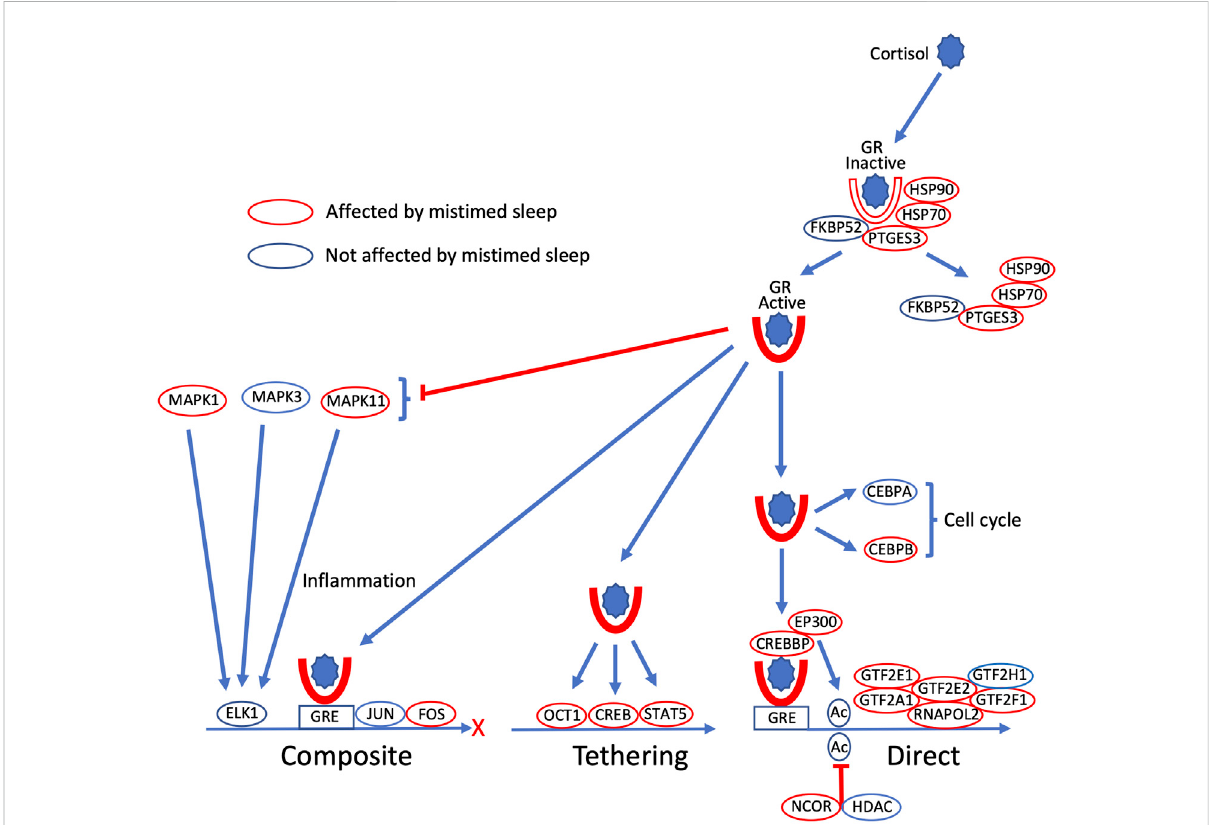
FIGURE 2 Glucocorticoid gene expression regulatory signalling pathways are disrupted by sleeping out-of-phase. Cortisol binds to cytoplasmic glucocorticoidreceptors (GR),whichbecomeactivewhenasetofboundchaperoneproteins(FXBPS2,PTGES3,HSP70,HSP90)dissociatefromGR. Active GR regulates gene expression in three major ways: GR binds to glucocorticoid response elements (GRE) in conjunction with other transcriptionfactors(TFs;JUN,FOS)incompositeregulation;GRpromotesgeneexpressionbypositiveinteractionwithotherTFs(OCT1,CREB, STAT5) in regulation by tethering; in direct regulation, GR binding to GRE activates RNA polymerase two complexes (RNAPOL2, GTF2A1, GTF2E2, GTF2H1), which is also regulated by acetylation status (CREBBP, EP300 acetylation; NCOR, HDAC deacetylation). GR also has non-genomic signallingtoregulatecellcyclecomponents(CEBPA,CEBPB),andinhibitstheproductionofin fl ammatorycytokinesviaMAPkinases(MAPK1,MAPK3, MAPK11).Withinthesesignallingpathways,allencodingtranscriptswhoseexpressionpro fi leisdisruptedbysleepingout-of-phasearehighlightedby red ovals (unaffected encoding transcripts indicated by a blue